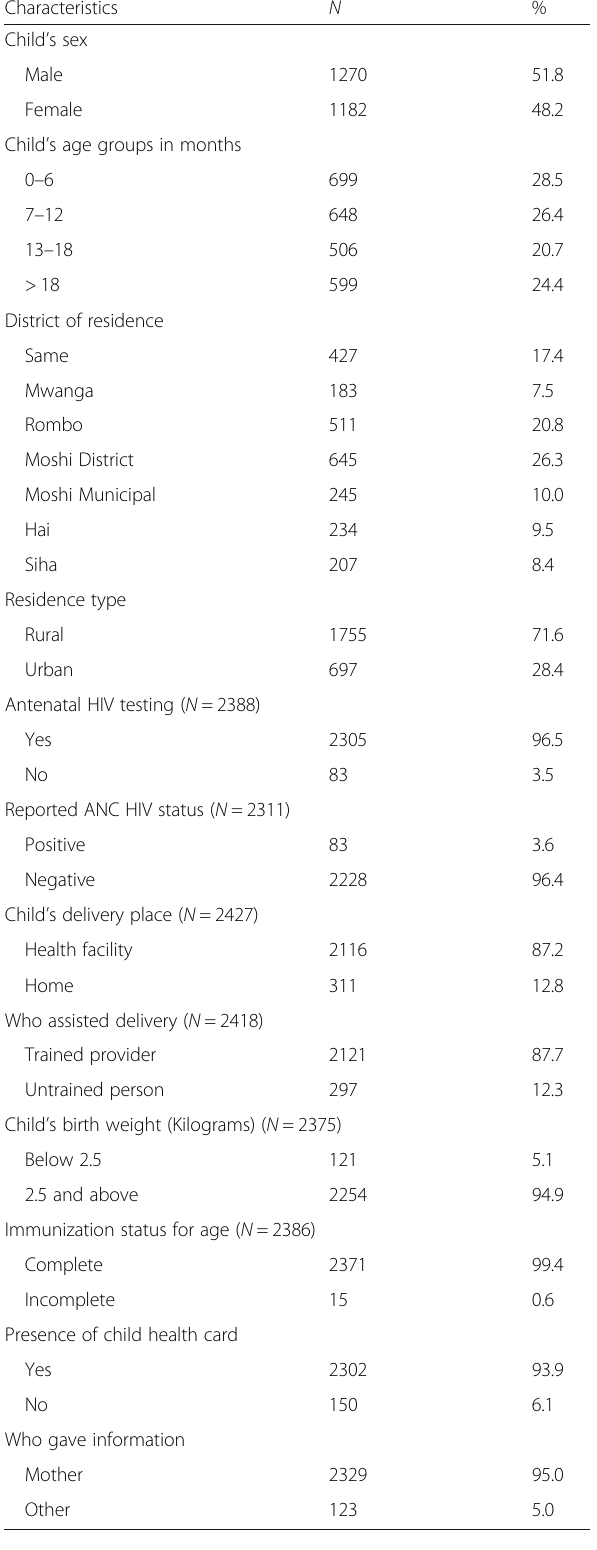
Table 1 Background characteristics of 2452 children of 0 – 36 months of age in Kilimanjaro region, Tanzania